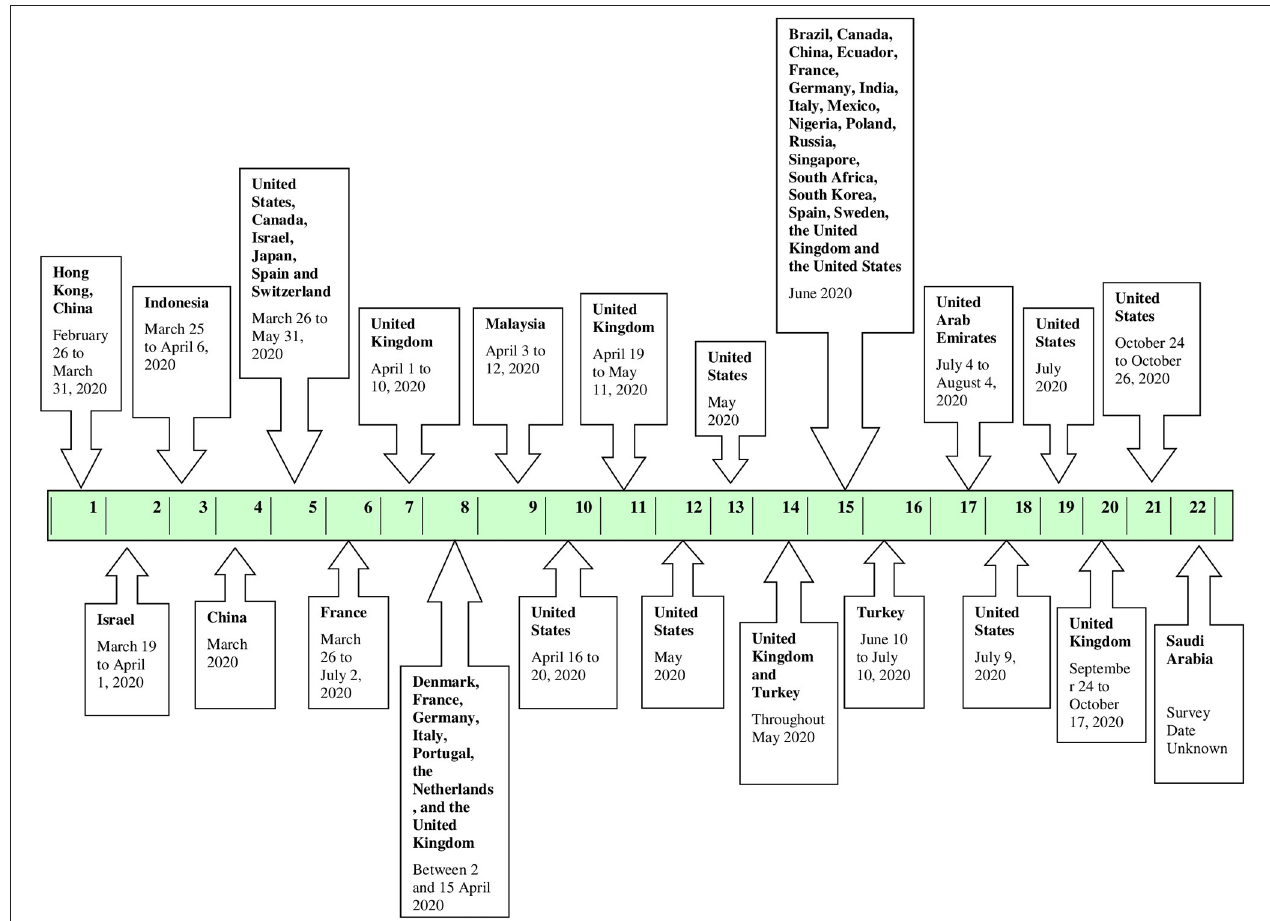
FIGURE 2 | Timeline of the COVID-19 vaccine surveys conducted